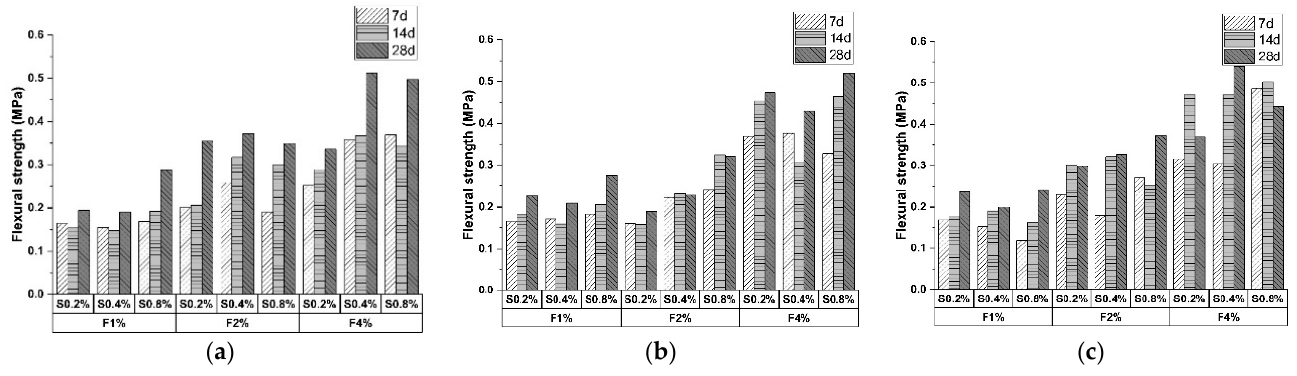
Figure 6. Flexural strength of 10% cement specimen with ( a ) 10% C&D waste; ( b ) 20% C&D waste; ( c ) 30% C&D waste (Note: S represents sodium sulfate; F represents polypropylene fiber).